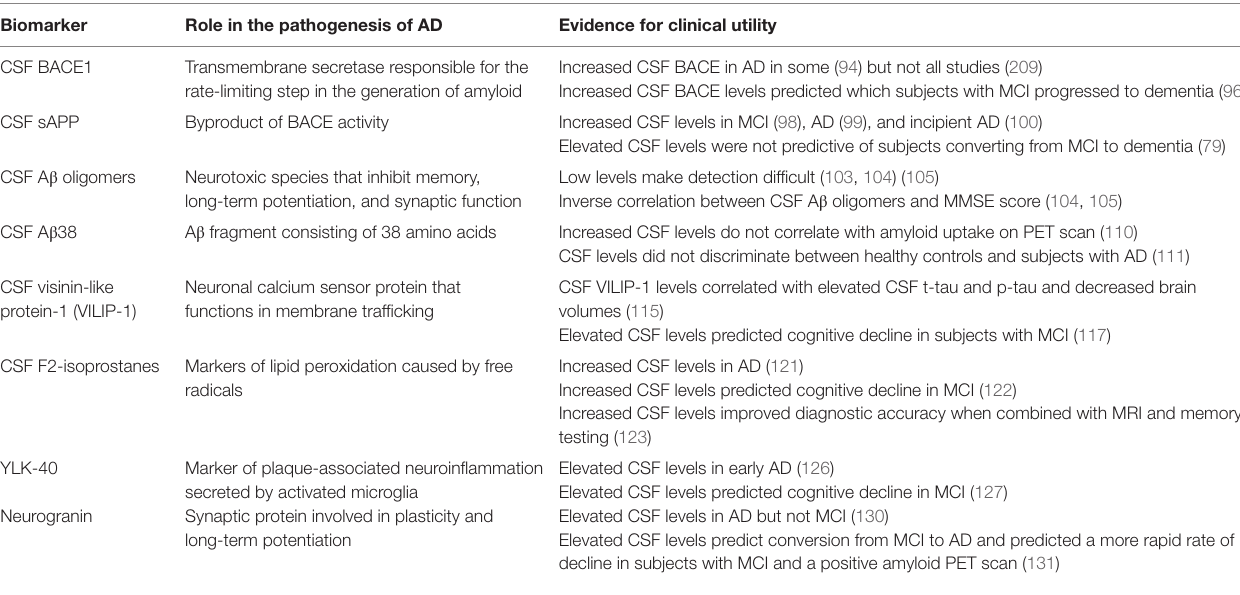
TABLe 1 | Candidate CSF